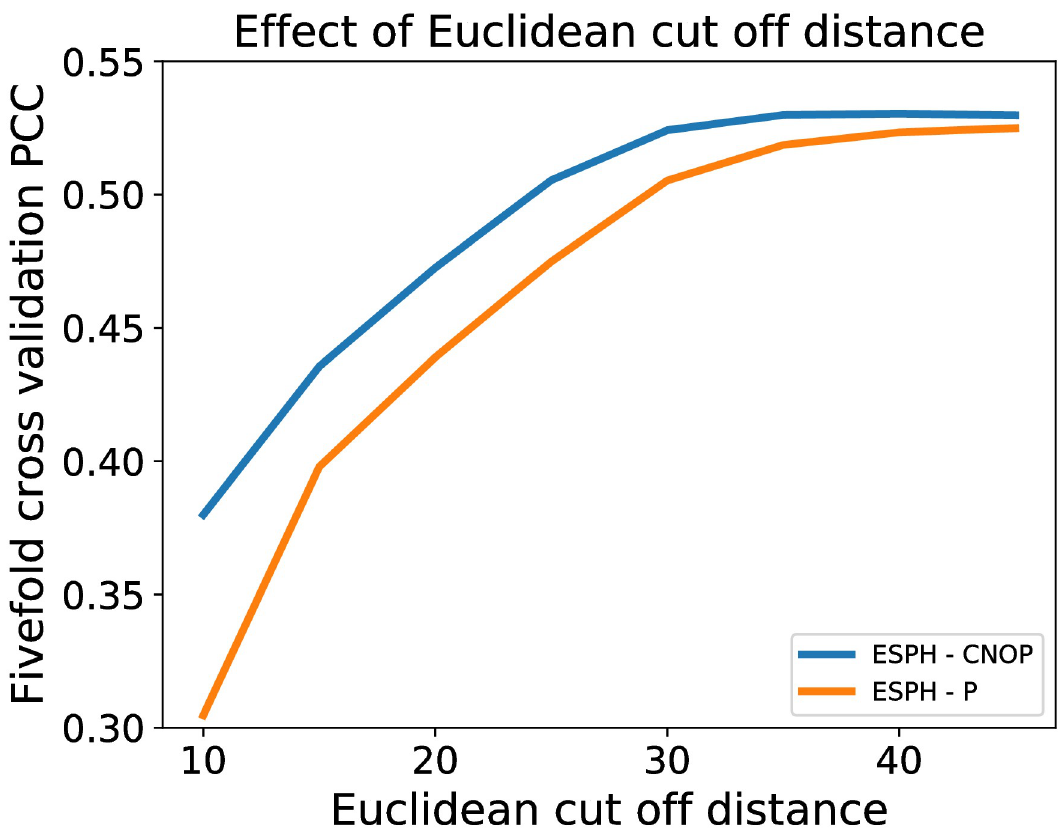
Fig 2. Effect of Euclidean cut-off distance on RF using the topological features from element P and all four elements with a fixed F/E ratio of 1.0 and bin size of 0.15 Å .